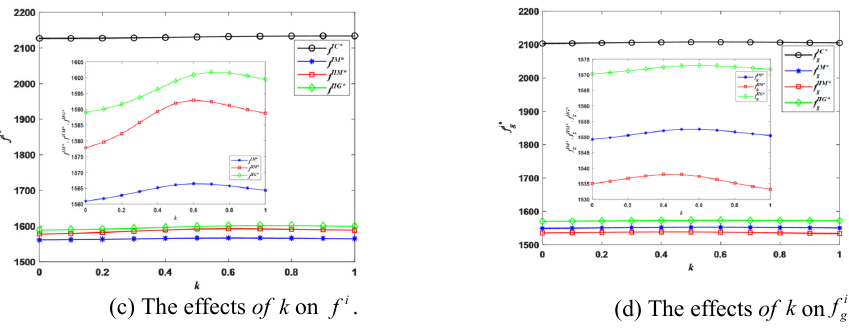
f , i f , i f and i g f . m r